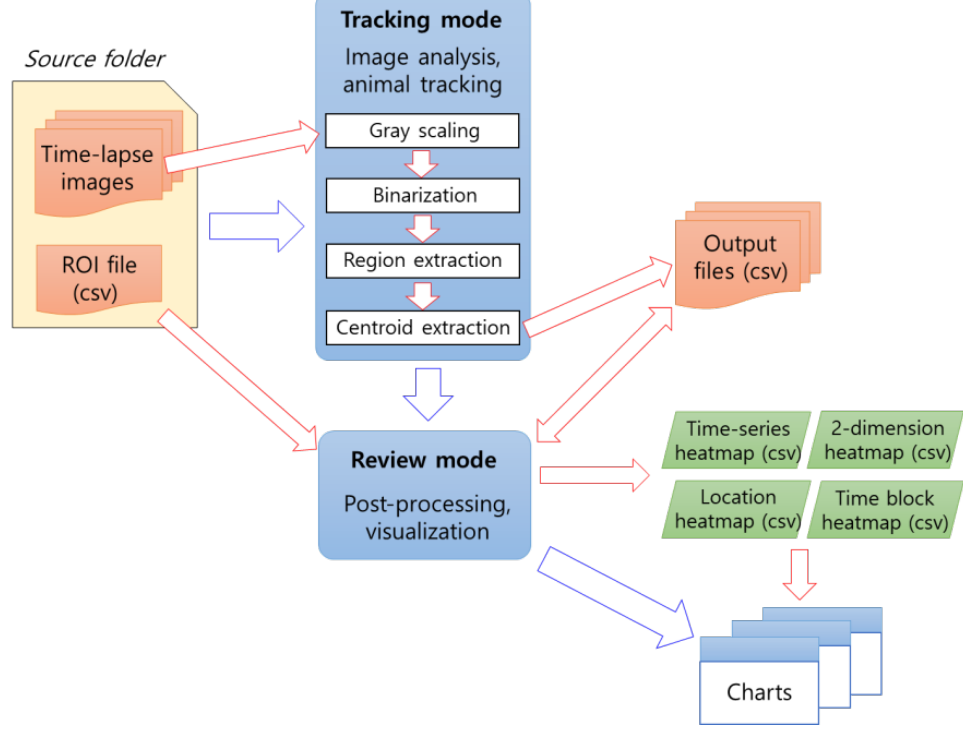
Figure 1. Software components and processing flows. Red and blue arrows indicate data flow and user action flow, respectively.